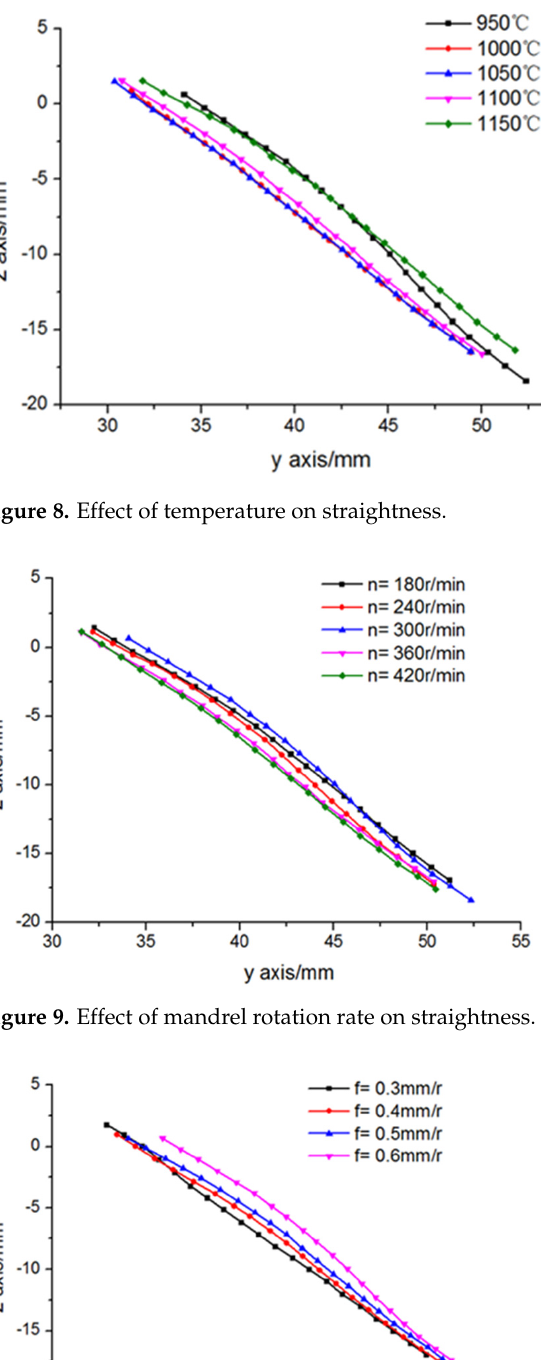
Figure 7. Distribution of sampling points for straightness calculation.